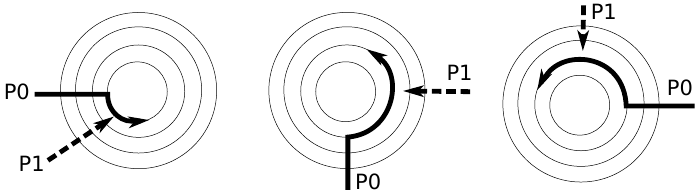
Figure 12. Blocked packet caused by different arrival times.